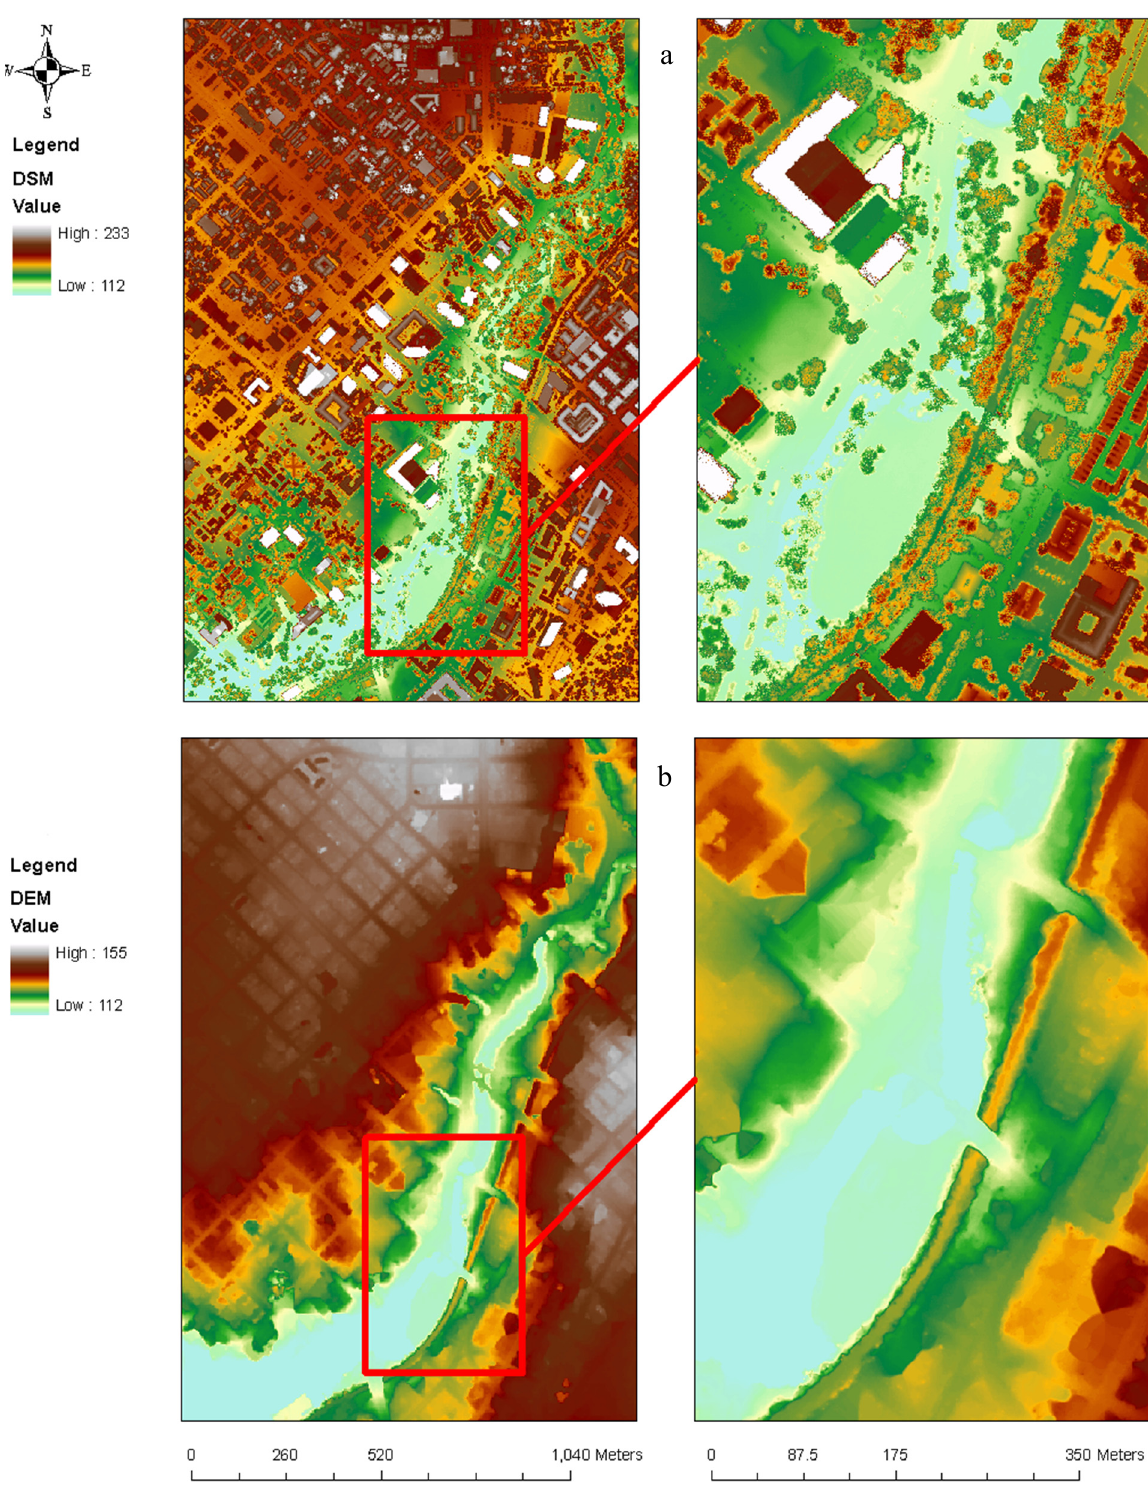
Figure 5. LiDAR-derived ( a ) DSM and ( b ) DTM for the study site (unit: meters; cell size: 1